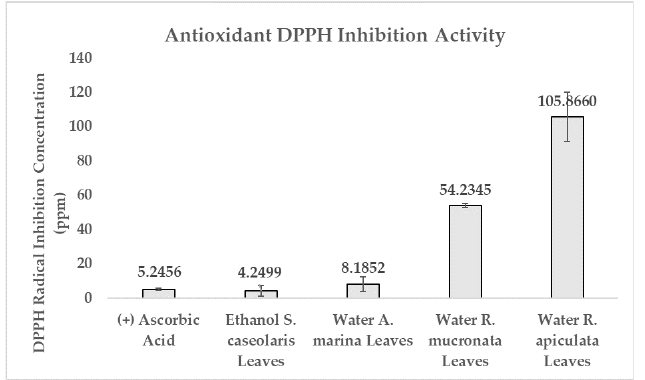
Figure 1. Comparison of DPPH IC 50 between controlled ascorbic acid and each mangrove species extract. Result values and error bars were plotted in the form of mean ± standard deviation, respec- tively.